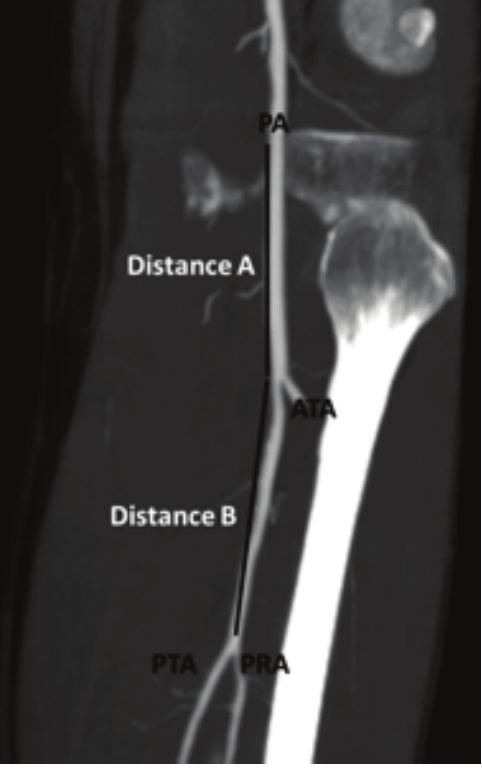
Figure 1: The MIP MDCT image of the right lower extremity shows measurements of distance A and distance